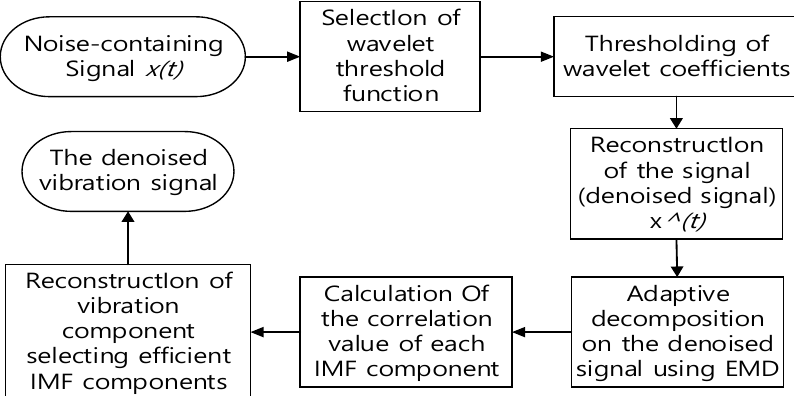
Figure 2. Flowchart of the wavelet-EMD denoising method.